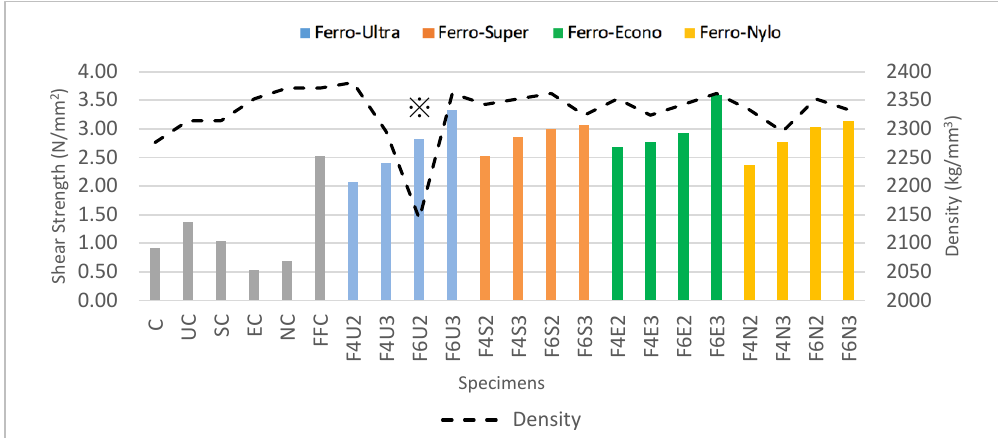
Figure 6. Influence of density on HyFRC shear strength ( ※ = irregular density).